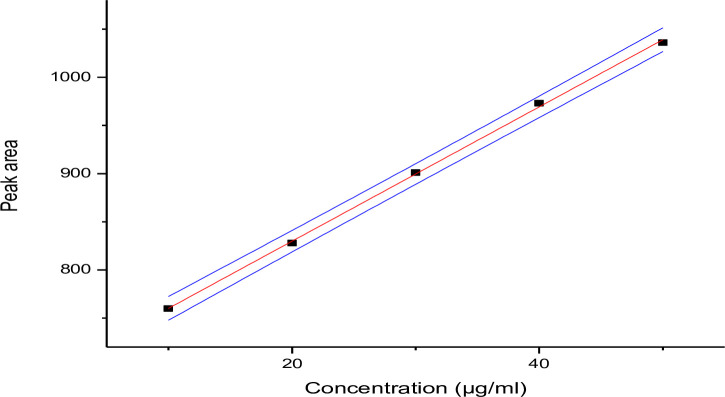
Calibration curve of sulfamethoxazole.